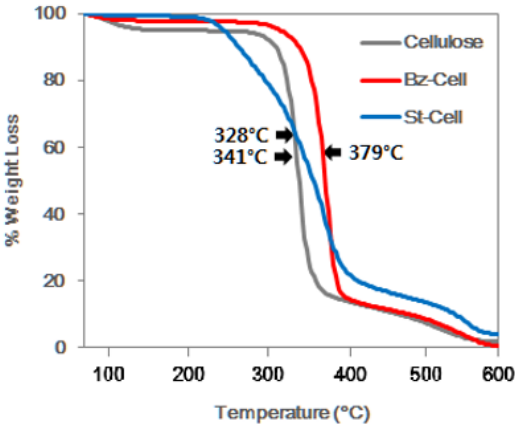
Figure 4. Thermal Gravimetric Analysis (TGA) analysis of cellulose (gray); Bz-Cell (red); and St-Cell (blue). Table 2. TGA data of cellulose, Bz–Cell, and St–Cell.